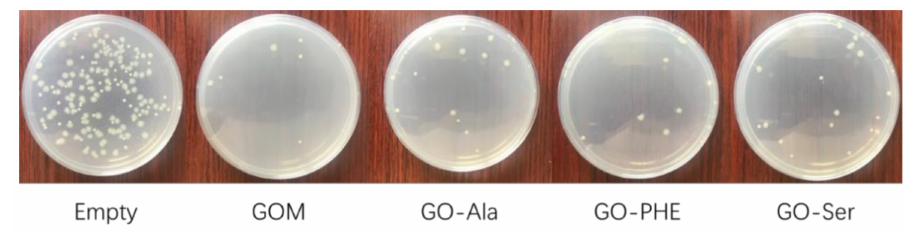
Figure 9. Antibacterial activity of GOMs against E. coli.